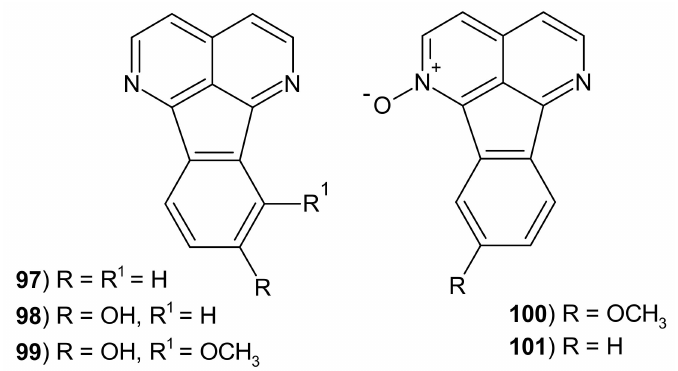
Figure 28. Structures of eupolauridine analogs 97 – 101